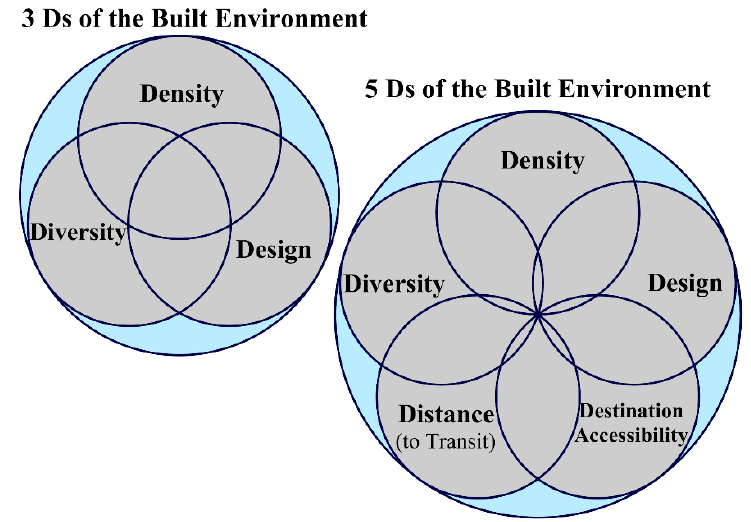
Figure 10. The most common dimensions of the built environment (Source: [92]).